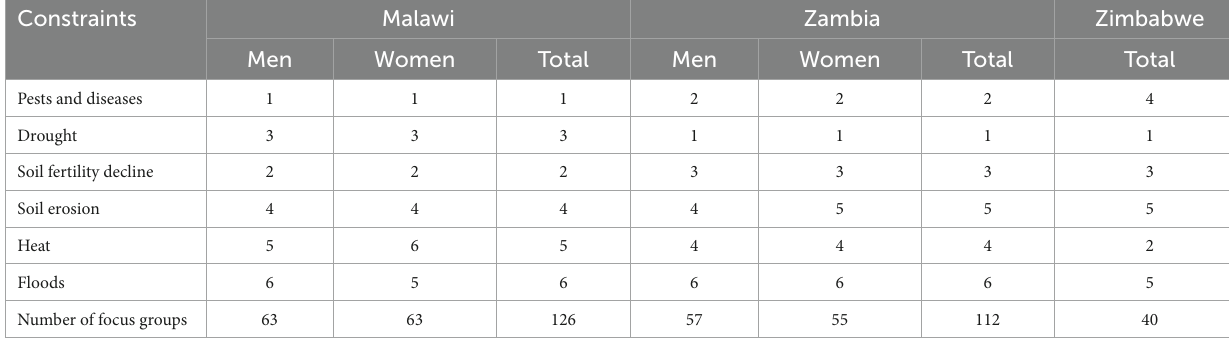
TABLE 3 Pairwise ranking results of agricultural production